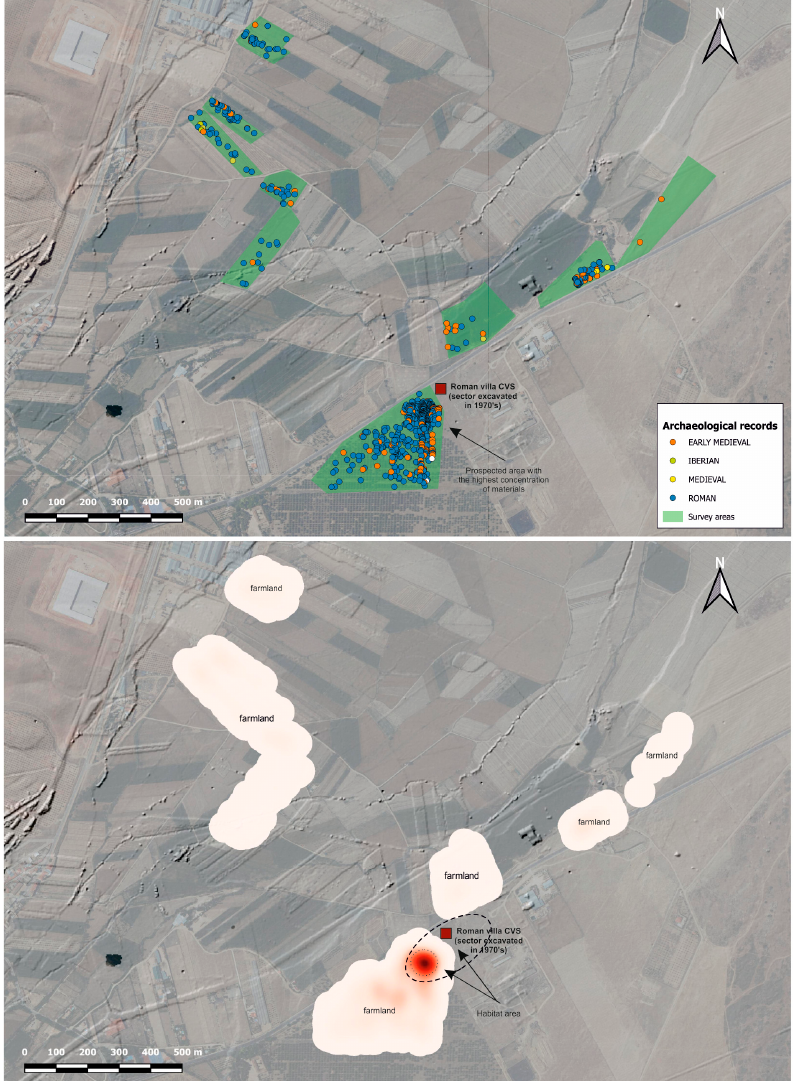
Figure 8. An image of the concentrations of diagnostic surface records and a kernel density map, in which the hottest areas correspond to the habitat zone during different periods (including the part to the east that was already excavated) and the coolest homogeneous areas are the cultivated fields.